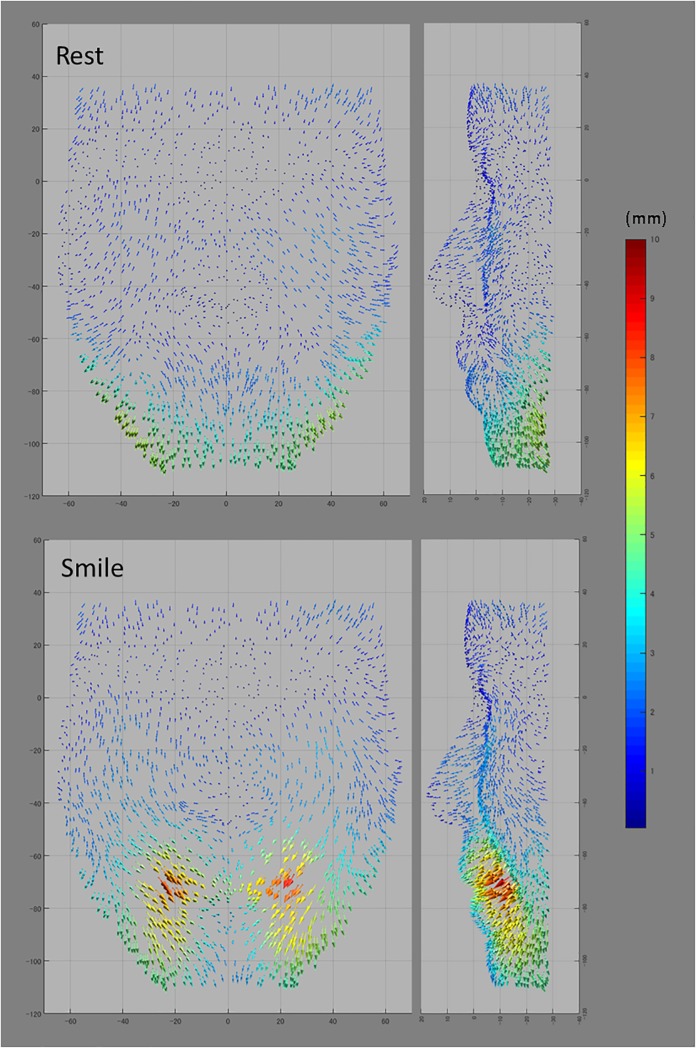
Vectors from the average mesh points of the younger group (arrow
base) to those of the older group (arrow apex).Greater magnitudes are indicated by red and smaller magnitudes by blue.
(Left, frontal view; right, lateral view).